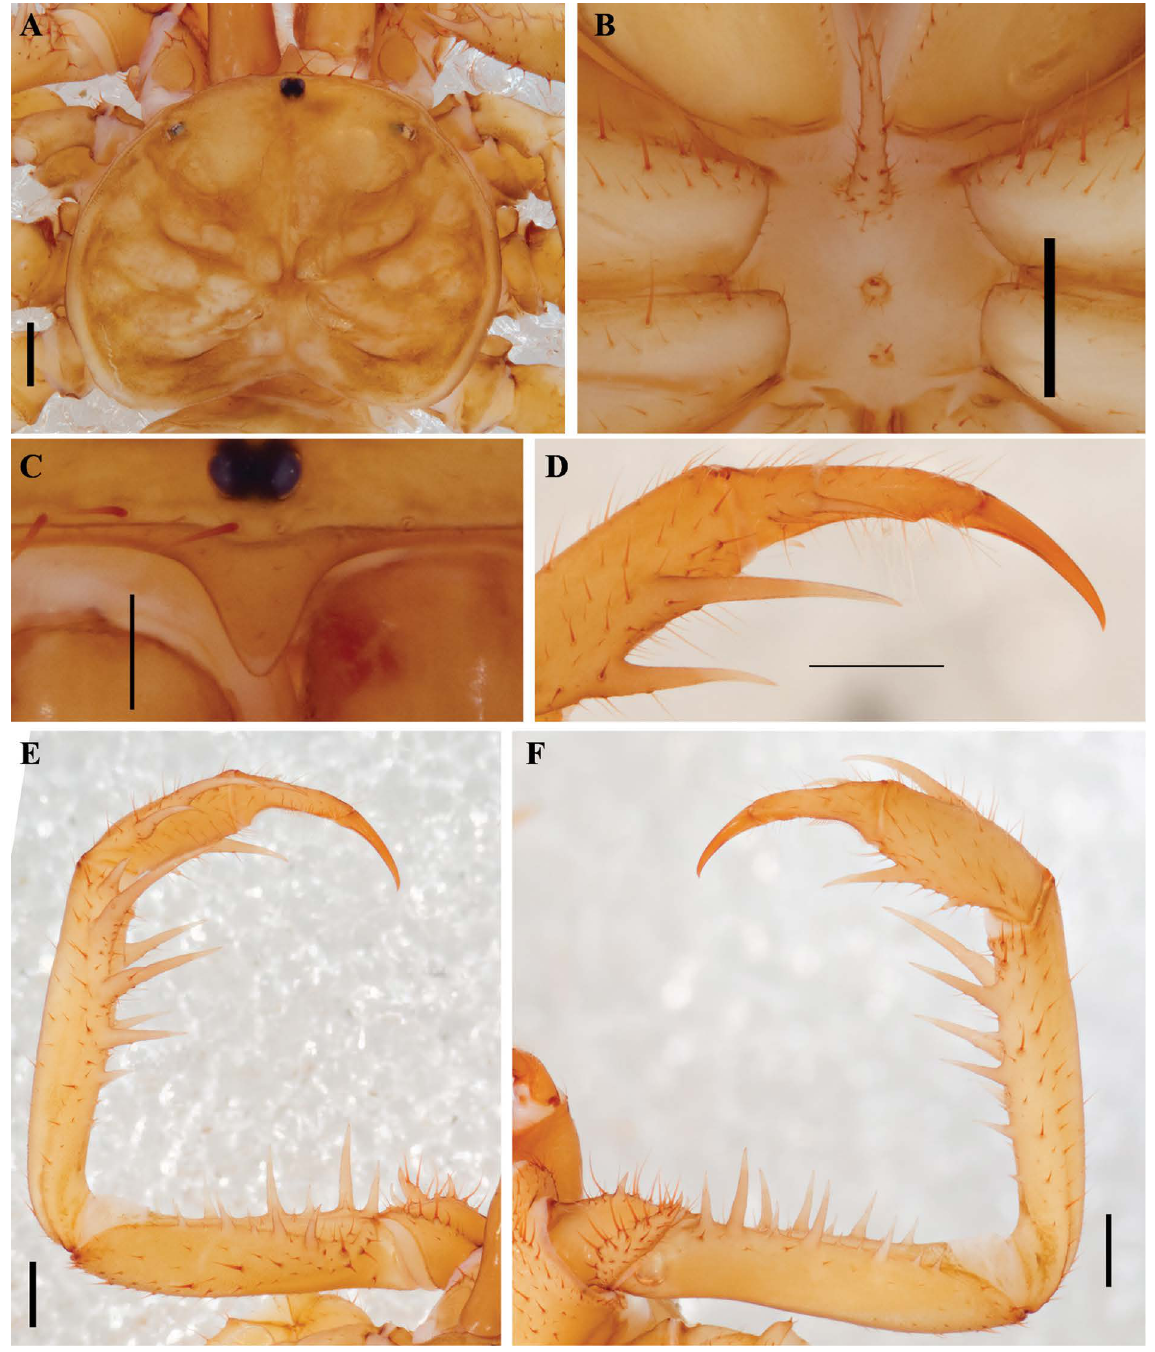
Fig. 120. Sarax rahmadii sp. nov. (WAM T63201), general morphology, ♂. A . Carapace, dorsal view. B . Sternum, ventral view. C . Frontal process. D . Pedipalp tarsus, frontal view. E . Pedipalp, dorsal view. F . Pedipalp, ventral view. Scale bars: A–C = 0.5 mm; D–F = 1